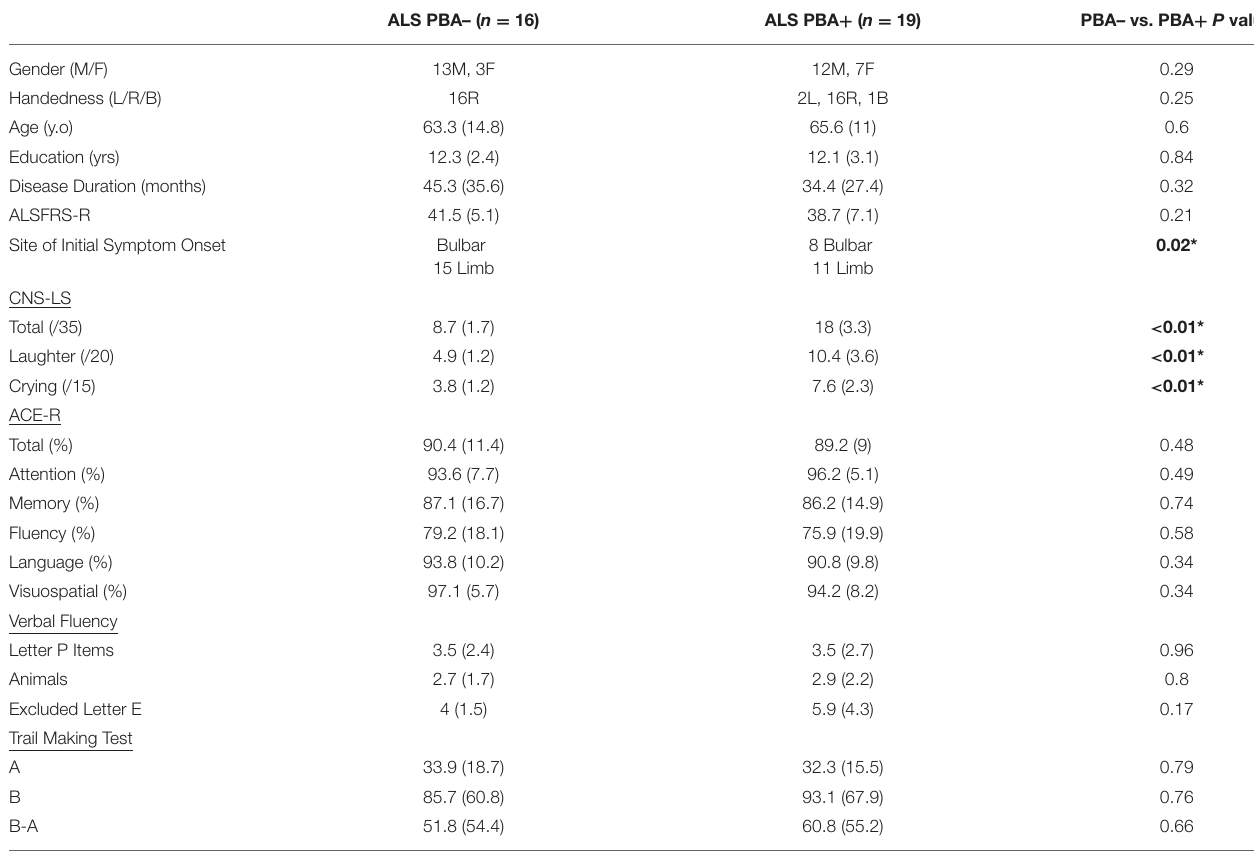
TABLE 1 | Demographic characteristics and clinical profile of ALS patients with and without pseudobulbar affect as defined by CNS-LS score ( ≥